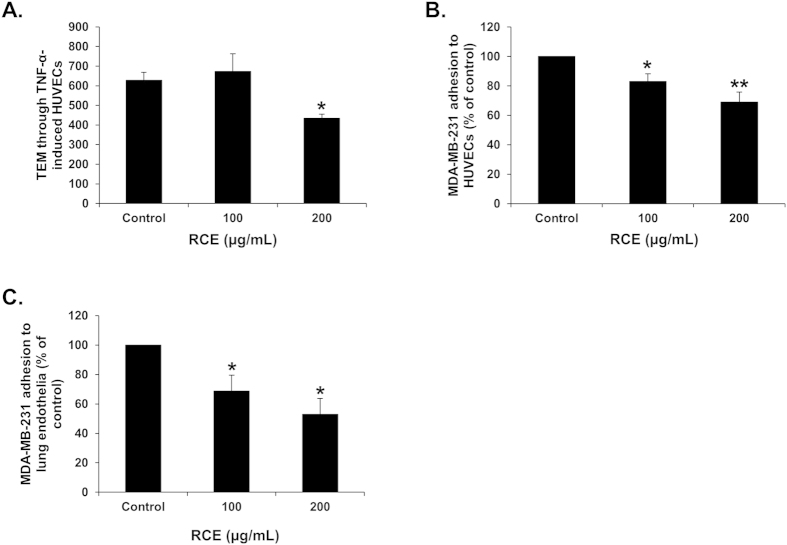
Rhus coriaria inhibits the migration of MDA-MB-231 cells across monolayer of TNF-α activated HUVECs and reduces their adhesion to HUVECs and lung endothelial cells (HMVEC-L).(A) Inhibition of transendothelial migration of MDA-MB-231 through TNF-α stimulated HUVECs. Confluent monolayers of HUVECs were pre-incubated with TNF-α (25 ng/mL) for 6 h, and transendothelial migration was evaluated after overnight incubation at 37 °C. Values represent means ± SEM, n = 3. Statistical analysis was performed using one-way ANOVA (*p < 0.05, **p < 0.005). (B,C) Inhibition of adhesion of MDA-MB-231 cells to HUVECs (B) and HMVEC-L (C). MDA-MB-231 cells were treated overnight with vehicle (0.2% ethanol) or indicated concentrations of RCE then seeded on top of the confluent endothelial cells and allowed to adhere for 60 min as described in Materials and Methods. Adhesion of MDA-MB-231 cell was represented as percentage of cells that have adhered to HUVECs (B) or HMVEC-L (C). Data represent means ± SEM of three independent experiments. Statistical analysis was performed using one-way ANOVA (*p < 0.05, **p < 0.005).